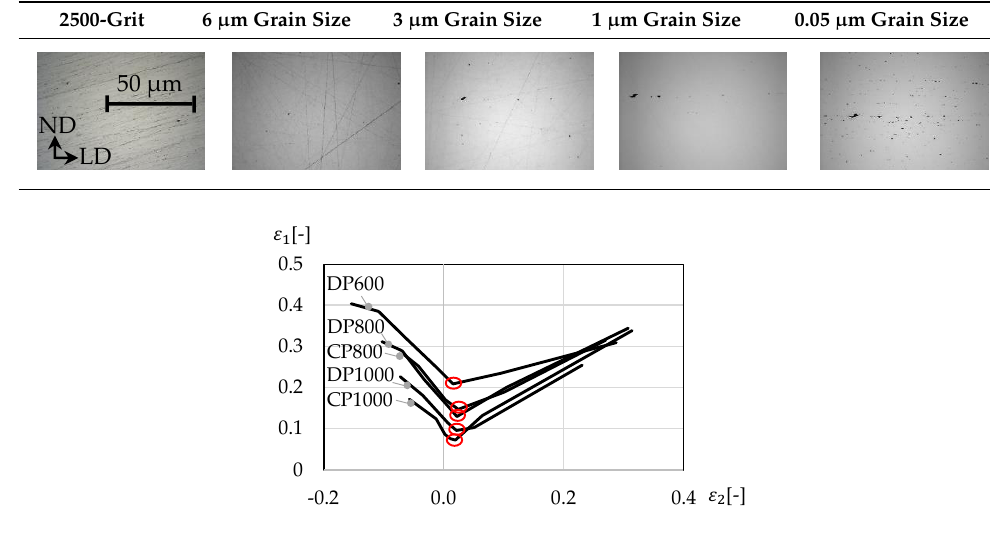
Figure A2. Forming limit diagram.